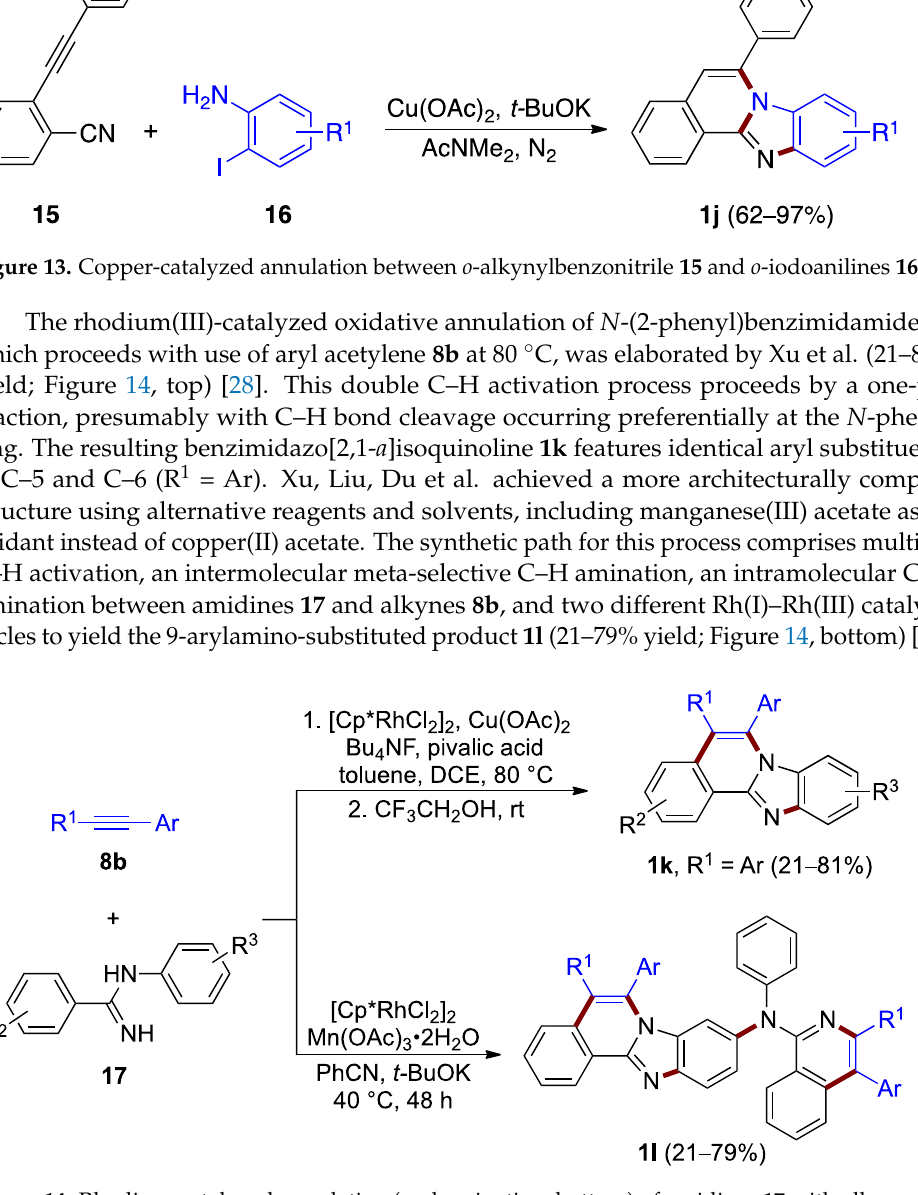
Figure 14. Rhodium-catalyzed annulation (and amination, bottom) of amidines 17 with alkynes 8b .